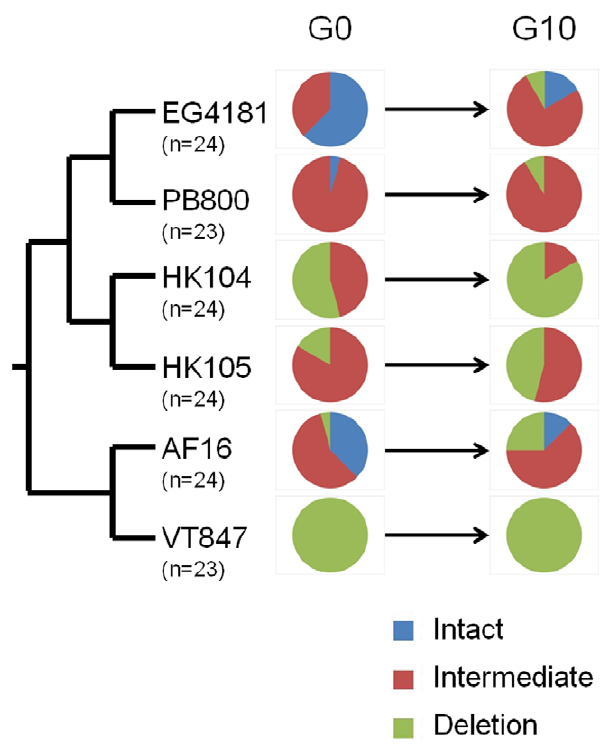
Figure 3. Changes in nad5 D mtDNA levels across ten genera- tions in MA lines. The pie charts illustrate changes in the relative proportions of the three nad5 D locus PCR band genotypes among the MA lines analyzed from a given C. briggsae strain. G0 indicates the proportions observed in MA line-specific progenitor samples; G10 indicates proportions observed after ten bottleneck generations. Numbers of MA lines analyzed are indicated below strain names.